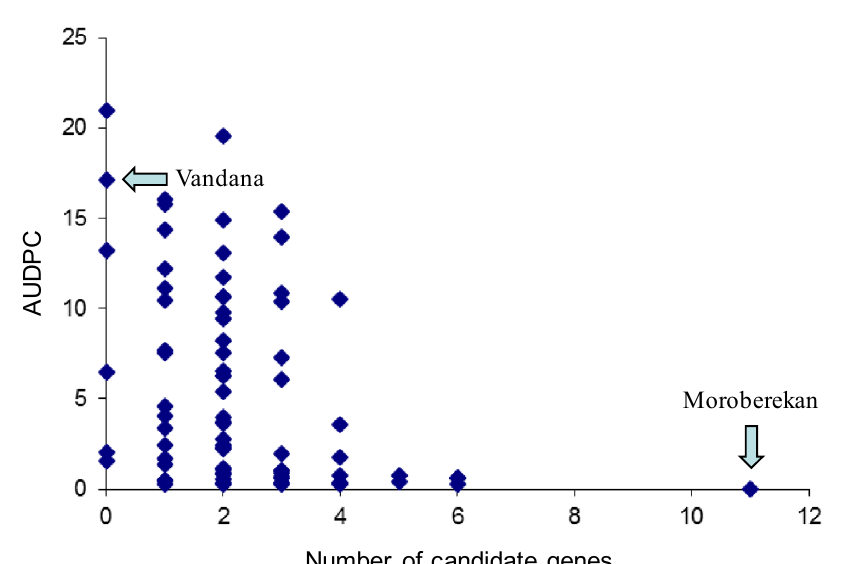
Figure 2. Performance of F 4 intermated lines carrying different number of candidate genes measured by area under the disease progressive curve (AUDPC) in Almora,